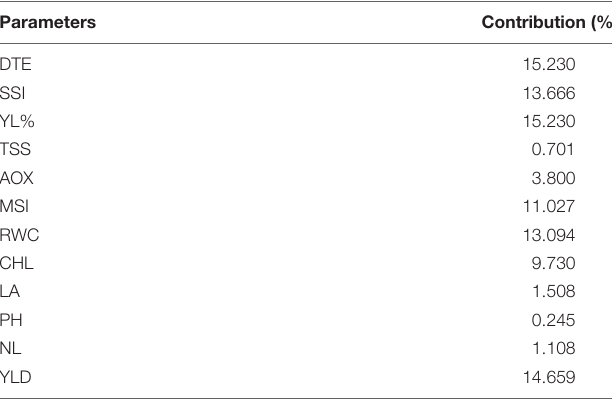
TABLE 7 | Contribution of different physiological, biochemical and yield traits toward genetic divergence in 100 onion genotypes. Parameters